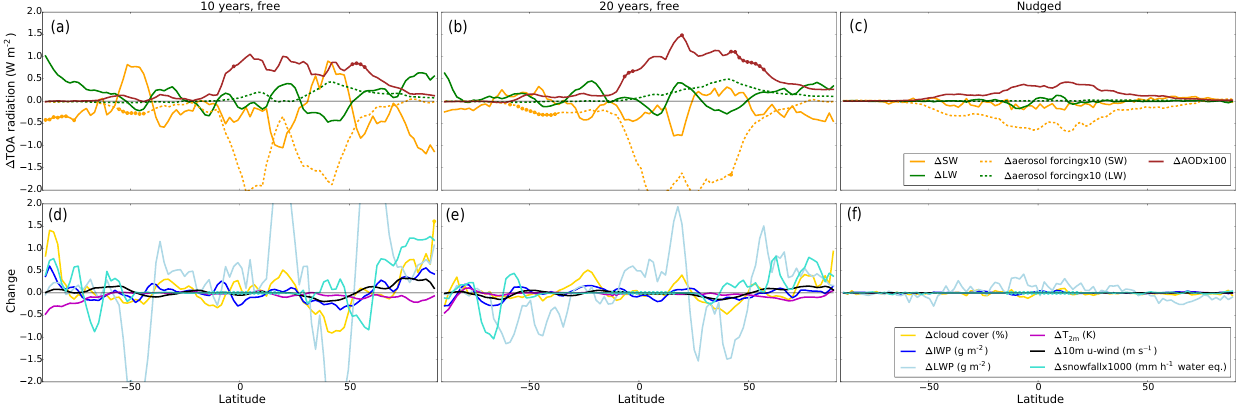
Figure 12. (a–c) Zonal, multi-year mean changes (“MOA”–“noMOA”) in the top-of-atmosphere (TOA) solar (SW) and terrestrial (LW) radiation in all-sky conditions, the corresponding changes in aerosol forcing at the TOA scaled up by an order of magnitude, and the change in aerosol optical depth (AOD) at the 550nm wavelength scaled up by 2 orders of magnitude to fit the same scale on the y axis. (d–f) Zonal, multi-year mean changes in cloud cover, ice water path (IWP), liquid water path (LWP), 2m temperature (T 2m ), 10m zonal wind (10m u wind), and water equivalent snowfall rate. Panels (a) and (d) are changes from the 10-year free-running simulations, (b) and (e) are changes from simulations identical to those on the left except they are extended for another 10 years, and (c) and (f) are from the nudged simulations. Small circles on the curves indicate statistical significance at the 99%